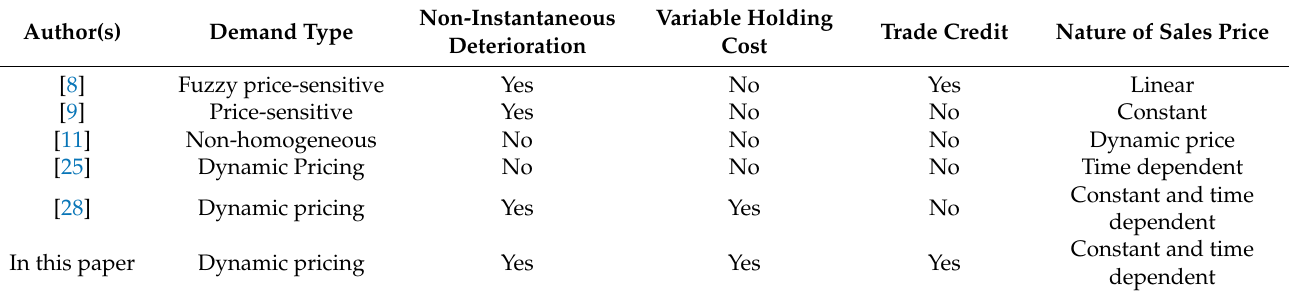
Table 1. Gap identification and summary of previous work for this